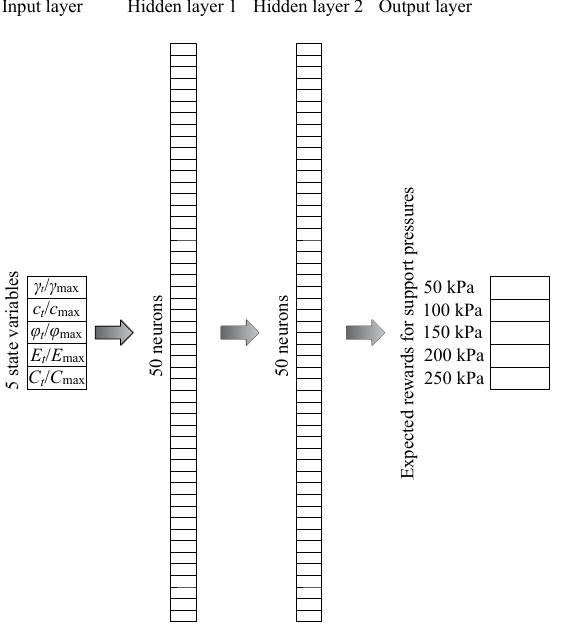
Figure 3. Architecture of the Deep Neural Network used for the choice of the support pressure based on the expected rewards and given the state of the TBM in the